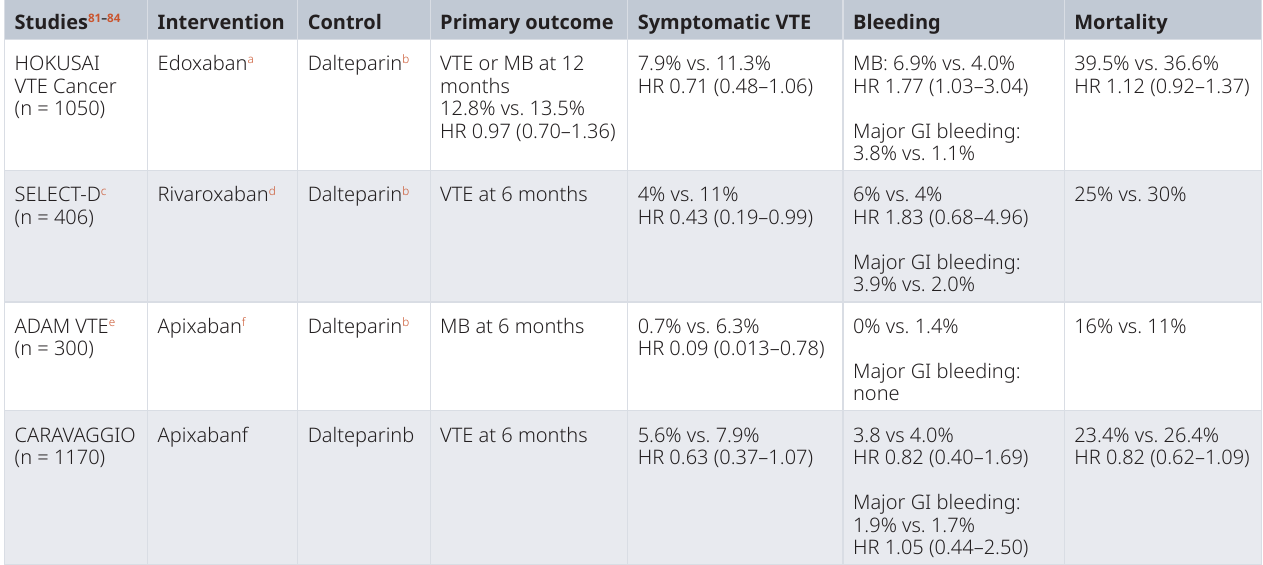
Table 1. Efficacy and safety of direct oral anticoagulants for treatment of cancer-associated venous thromboembolism. Studies